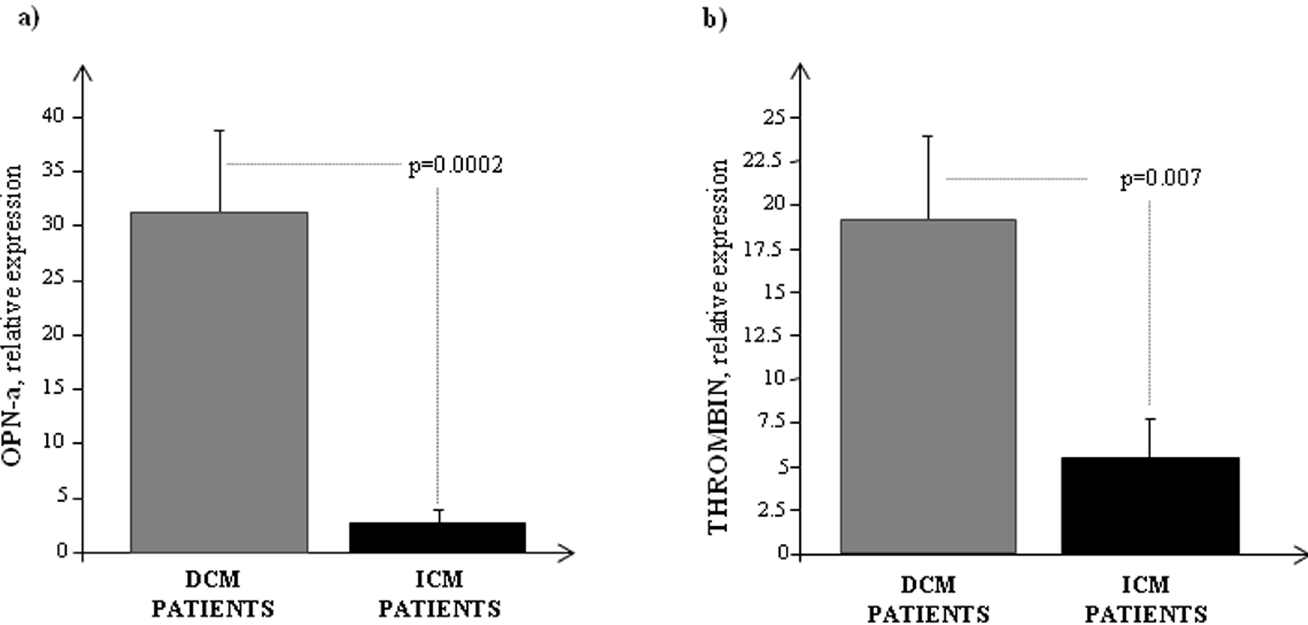
Fig 1. Transcriptional profile of OPN-a and thrombin in the heart of failing patients. a) OPN-a and b) thrombin mRNA expression measured by Real Time PCR in DCM and ICM patients. The three most stably expressed genes ( RPL13a , eEF1a , RPS4X ) was used for normalization of mRNA expression